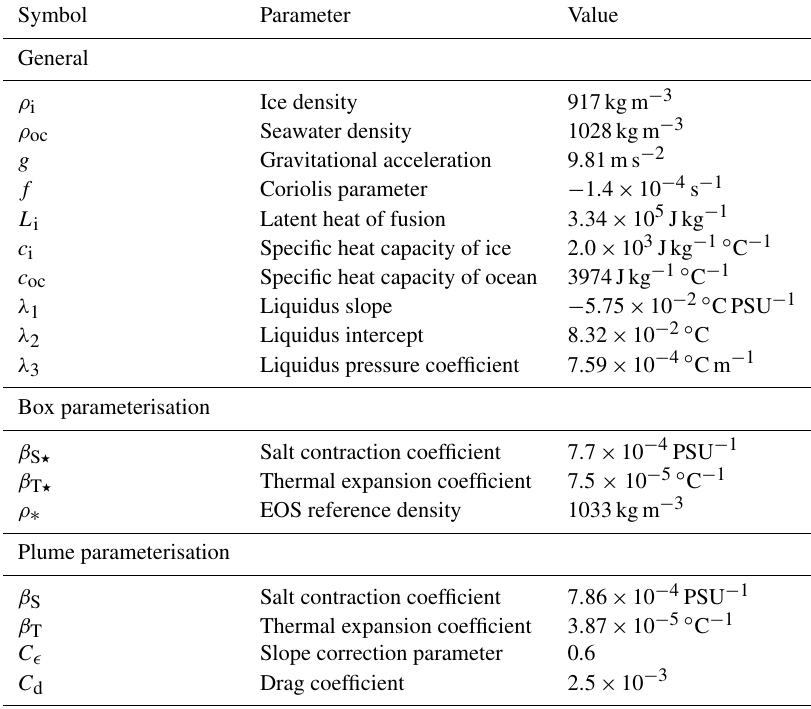
Table 2. Constant parameters used in the melt parameterisations. Note that due to different reference densities, β T and β S differ between the box and plume